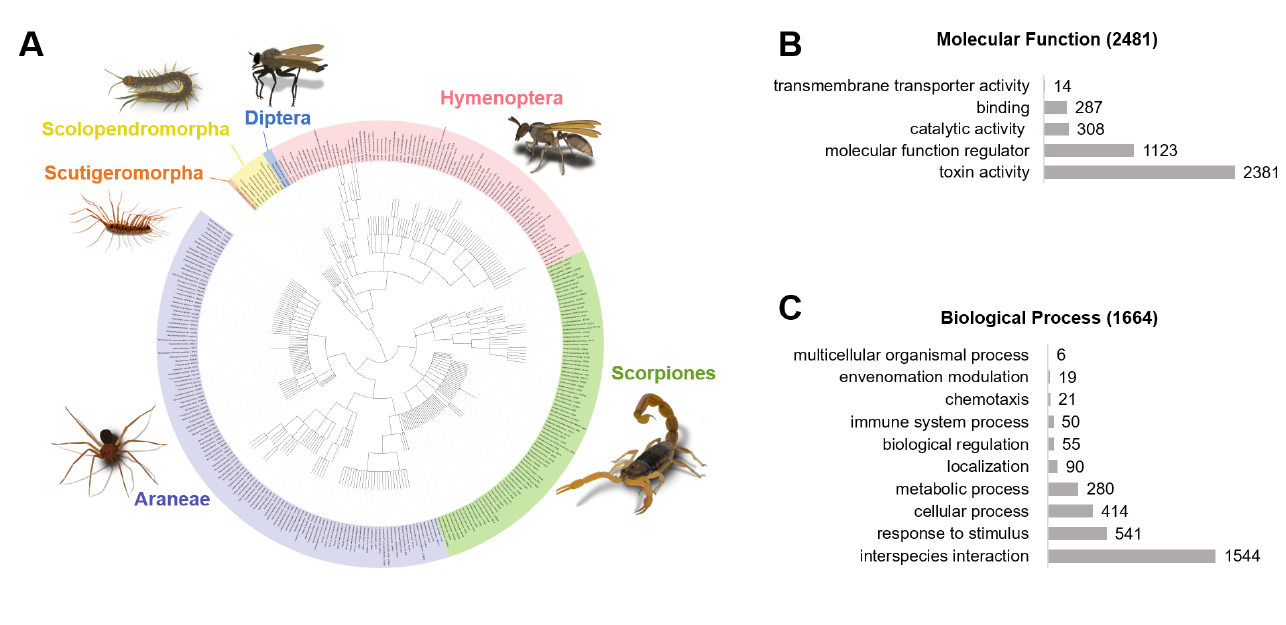
Figure 1. Arthropod venom proteins containing posttranslational modification (PTM) information in the keyword subsection of UniProtKB/Swiss-Prot Protein Database. (A) Phylogenetic tree of arthropods species, with PTMs information in the database (experimental plus putative), grouped by Order. Purple corresponds to Araneae, green to Scorpiones, pink to Hymenoptera, blue to Diptera, yellow to Scolopendromorpha and orange to Scutigeromorpha. (B) Gene ontology classification of arthropod venom proteins containing PTMs information based on their molecular function from 2481 entries and (C) biological process from 1664 entries. Phylogenetic figure was created in the interactive Tree of Life web server (http://itol.embl.de)